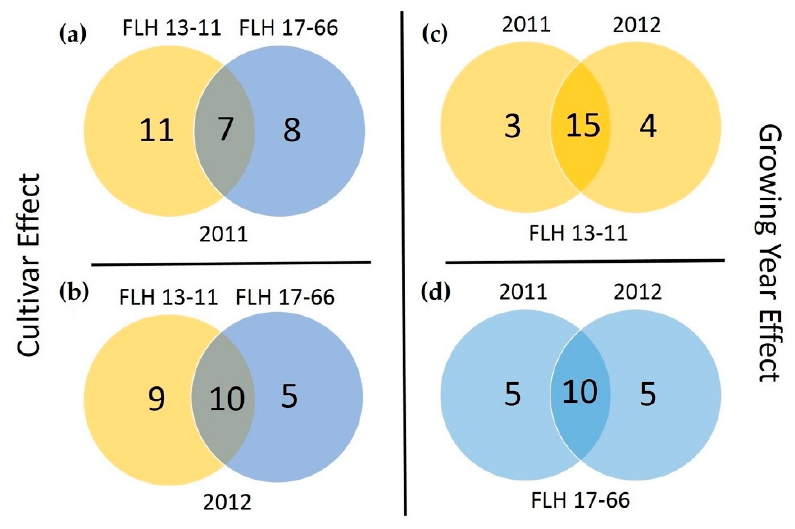
Figure 11. A Venn diagram showing effects of cultivars and cropping years on formation of 30 annotated metabolites. Arabic numerals are flavaan-3-ols and dimeric proanthocyanidins extracted from samples. Yellow and blue colors represent FLH13-11 and FLH 17-66, respectively.